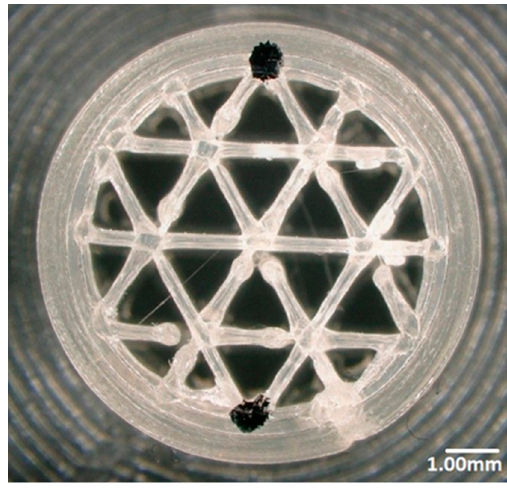
Figure 9. Two points were marked on the up surface of the samples.